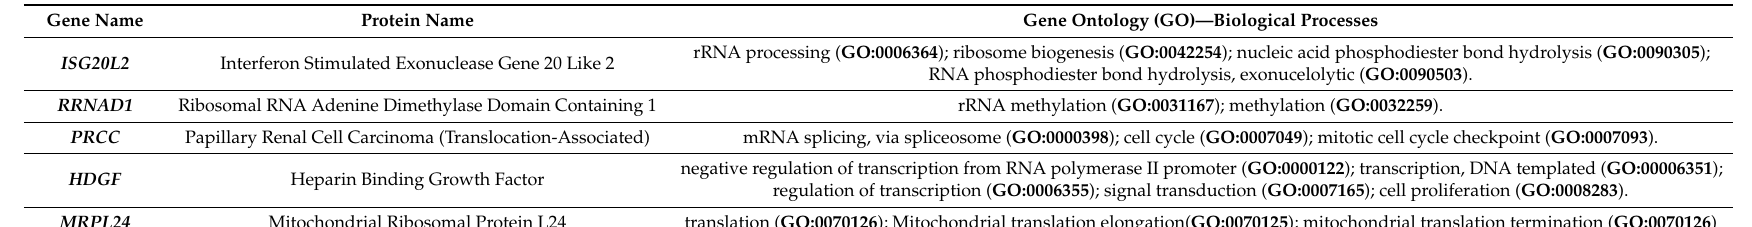
Table 2. Gene Ontology (GO) terms of PEAR1 interacting